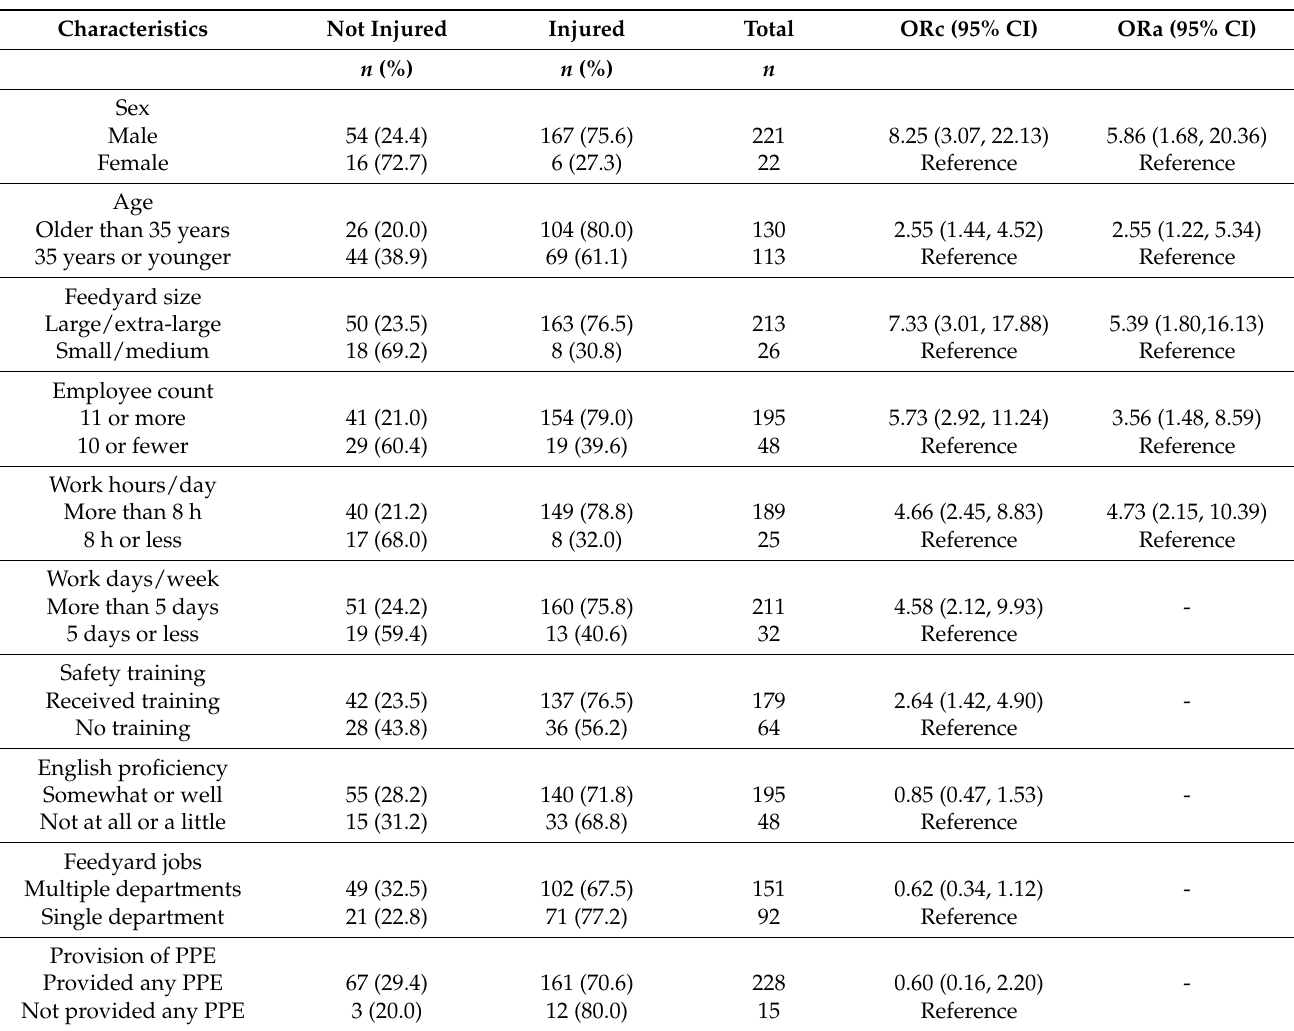
Table 3. Regression analysis of risk factors for